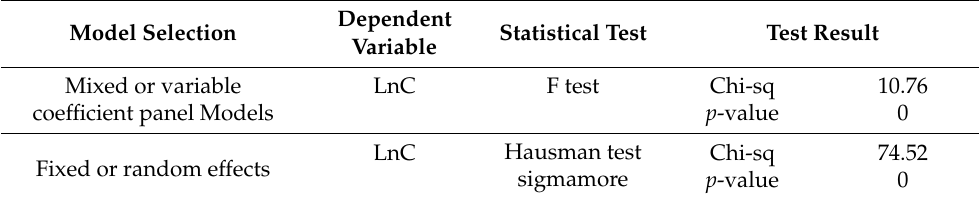
Table 4. F-test and Hausman test of the model.